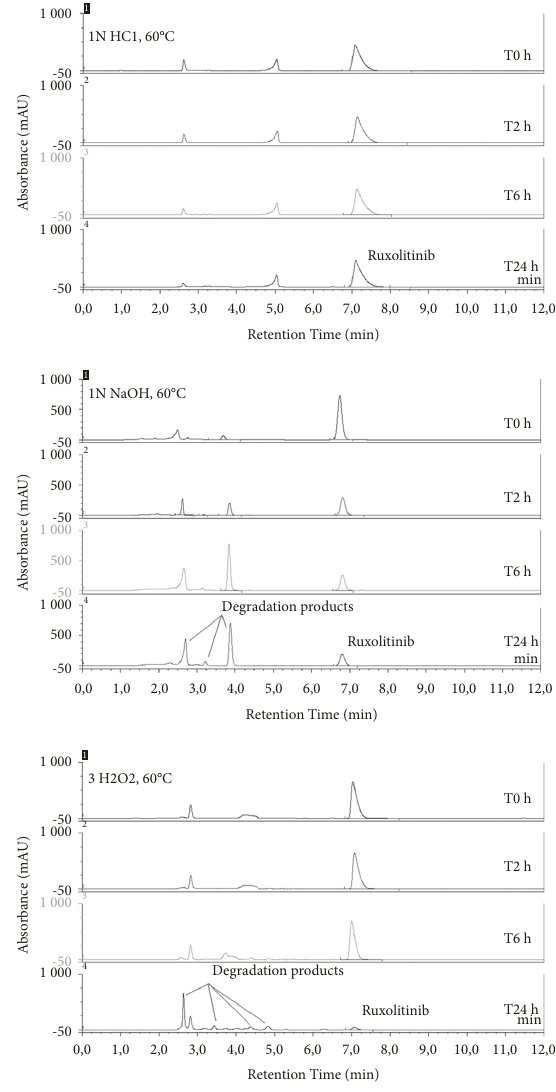
Figure 2: Chromatograms of ruxolitinib 200 μ g/mL in 1M HCl, 1M NaOH, and 3% H 2 O 2 stress condition stored at 60 ° C during